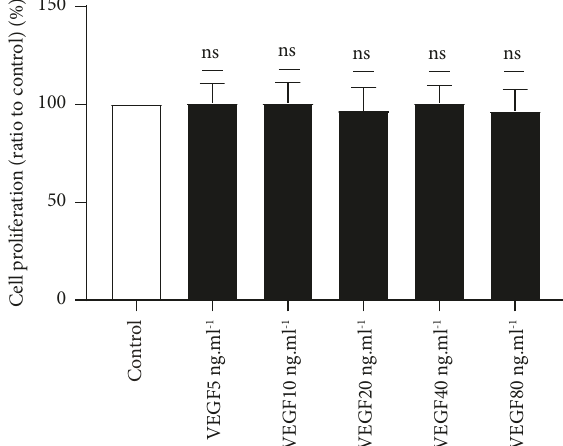
Figure 2: A CCK-8 assay was used to determine the effects of VEGF on ASMC proliferation. The 5 and − 80ng · ml − 1 concen- tration ranges showed no significant effect on ASMC proliferation activity (F � 0.713, P > 0 . 05). NS indicates no significant difference.